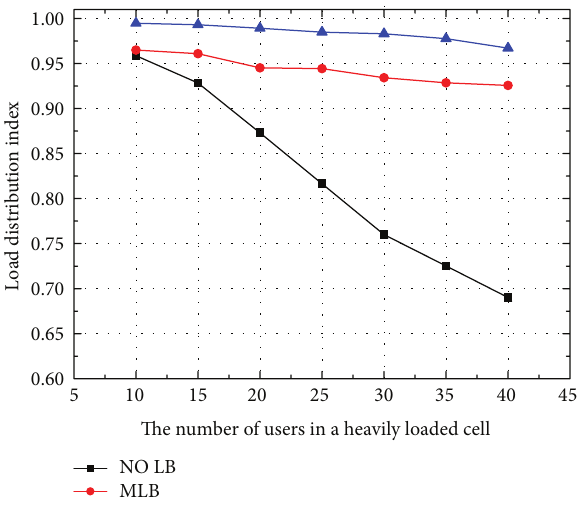
Figure 10: The load distribution index versus the number of users in a heavily loaded